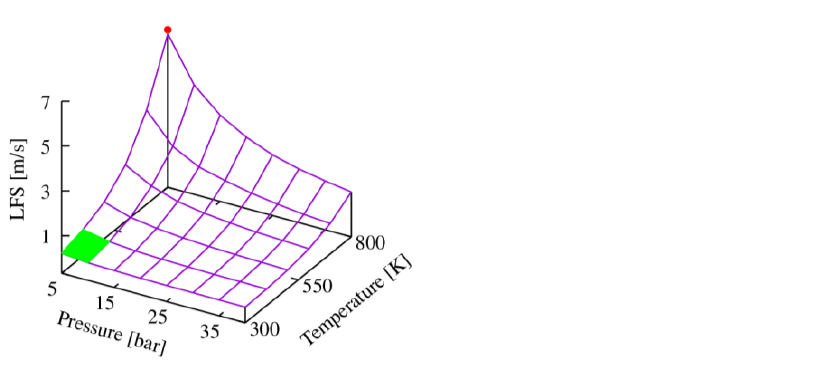
Figure 2. IDT trend as function of in-cylinder pressure: ( a ) 900 K and ( b ) 1200 K — equivalence ratio φ = 0.5. Kinetic scheme by Mevel et al. [26].